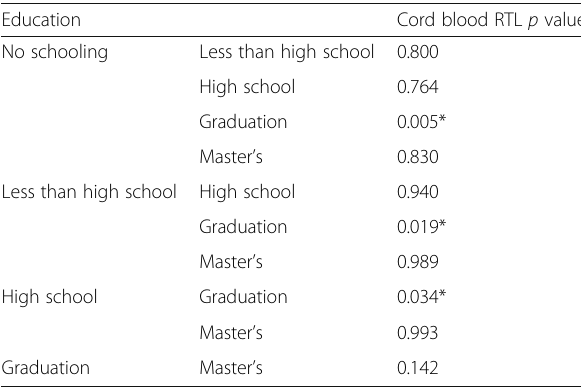
Table 3 Secondary analysis (Pairwise) between mother education and cord blood RTL